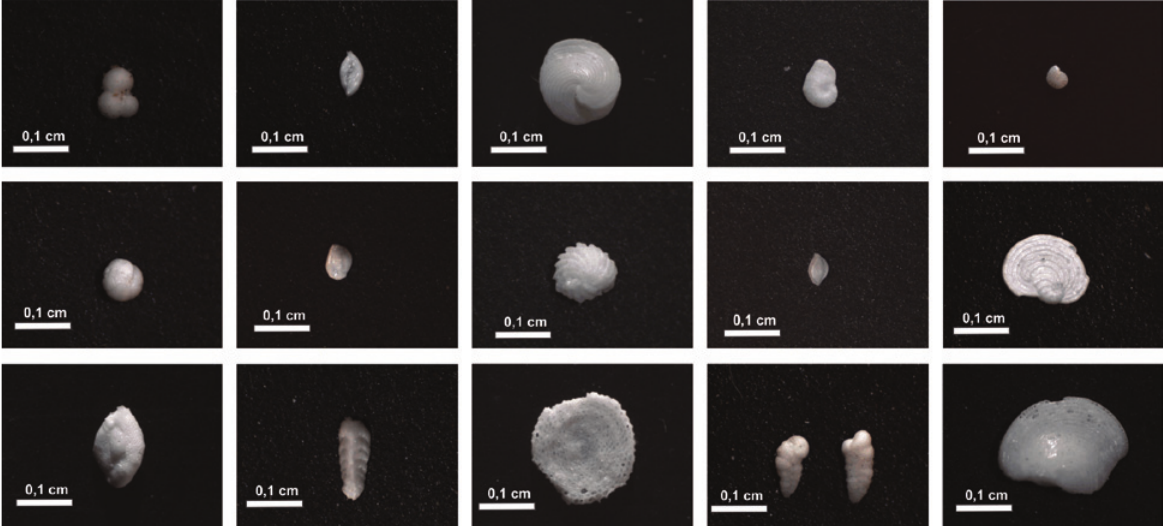
Figure 15 - Diversity of the foraminifera observed in the sediment samples collected inside the